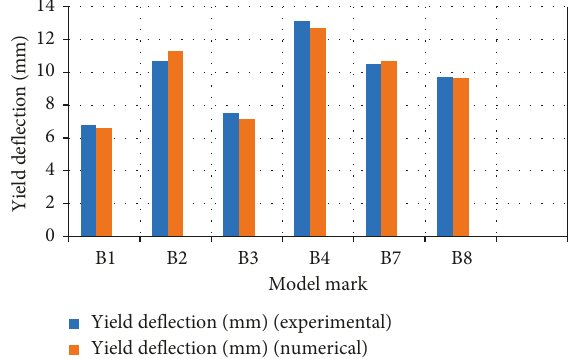
Figure 7: The experimental and numerical maximum deflection vs.